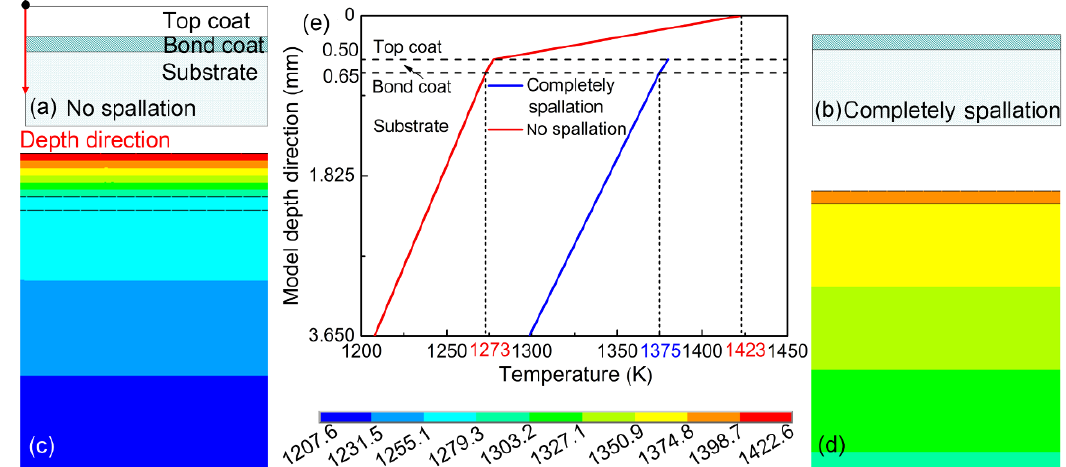
Fig. 2 Temperature distributions across a TBC system under different cases: (a) and (c) are two limit cases with no spallation and complete spallation, respectively; (b) and (d) are the temperature distribution corresponding to (a) and (c), respectively. (e) Temperature distribution along the depth direction for these two